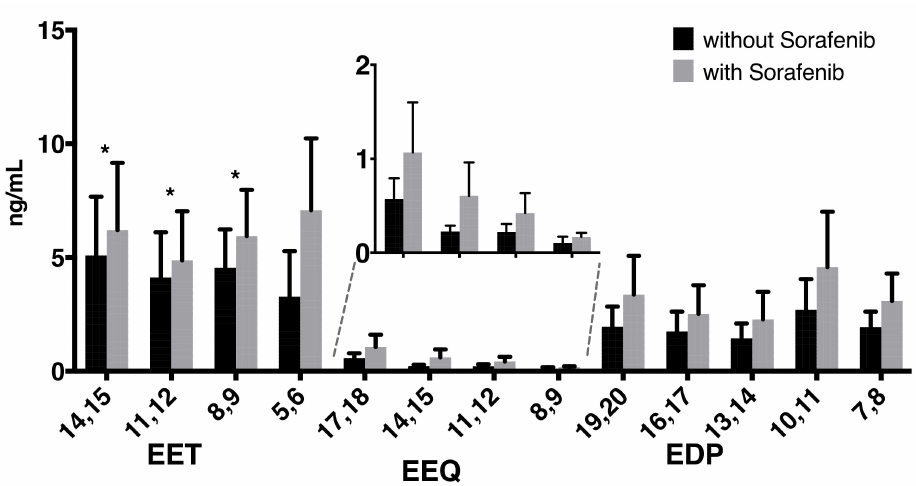
Figure 1. Concentrations of epoxy metabolites without or with concomitant sorafenib treatment. Analysis of epoxy metabolites derived from the omega-6 fatty acid arachidonic acid (AA) (epoxyeicosatrienoic acids, EETs) and from the omega-3 fatty acids eicosapentaenoic acid (EPA) (epoxyeicosatetraenoic acids, EEQs) and docosahexaenoic acid (DHA) (epoxydocosapentaenoic acids, EDPs) in a total of n = 6 patients with hepatocellular carcinoma (HCC) receiving sorafenib treatment (* p <